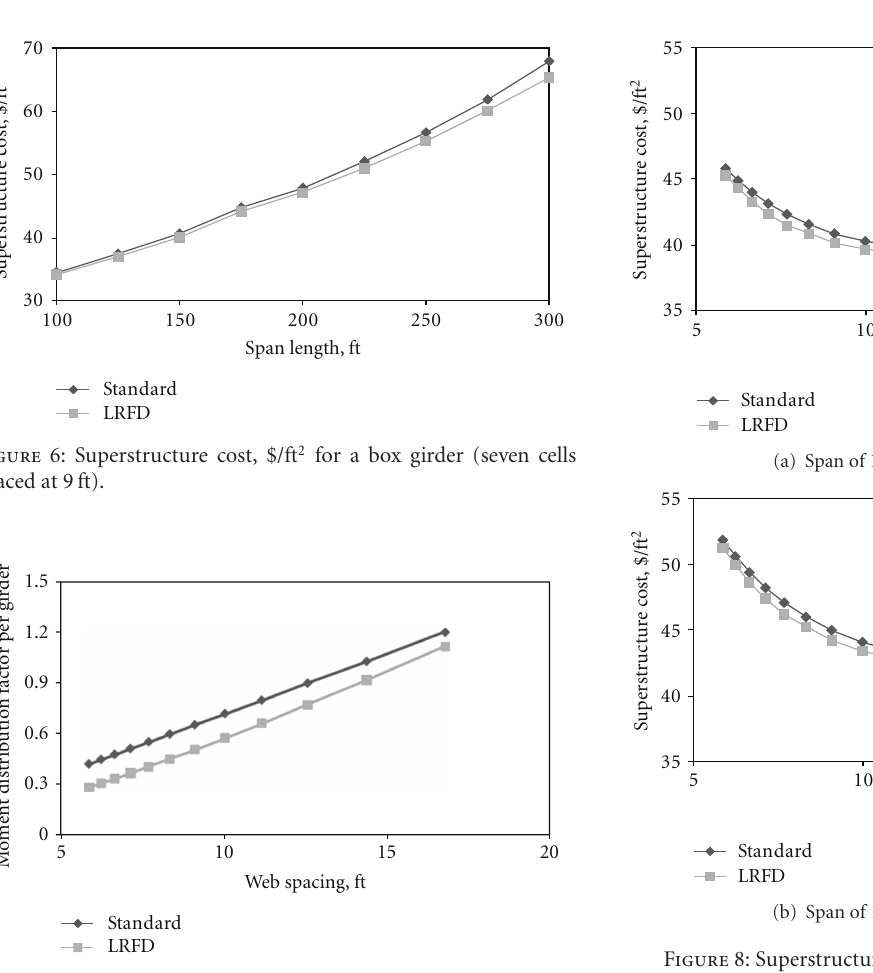
Figure 7: Distribution factors for box girder (150 ft span, 100 ft width, and varying web spaces).